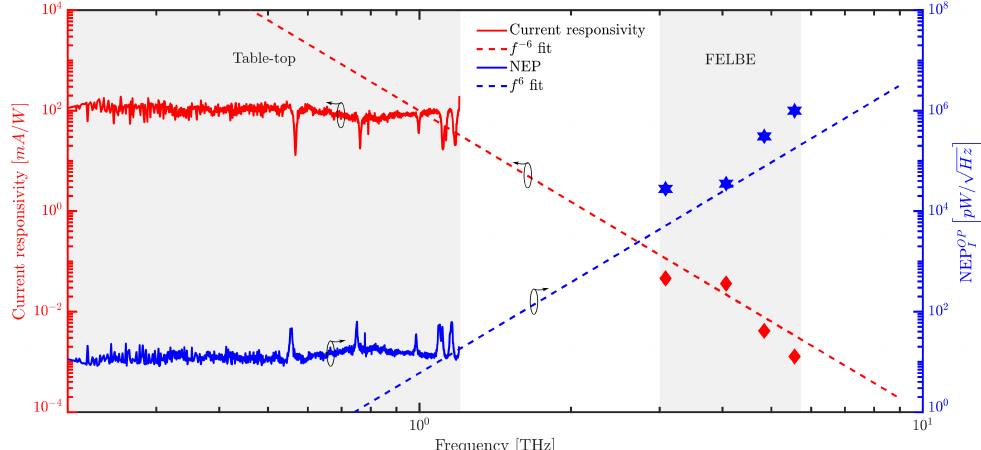
Figure 6. SD THz detector responsivity and NEP comparison with table-top and FELBE using the lock-in measurement technique.